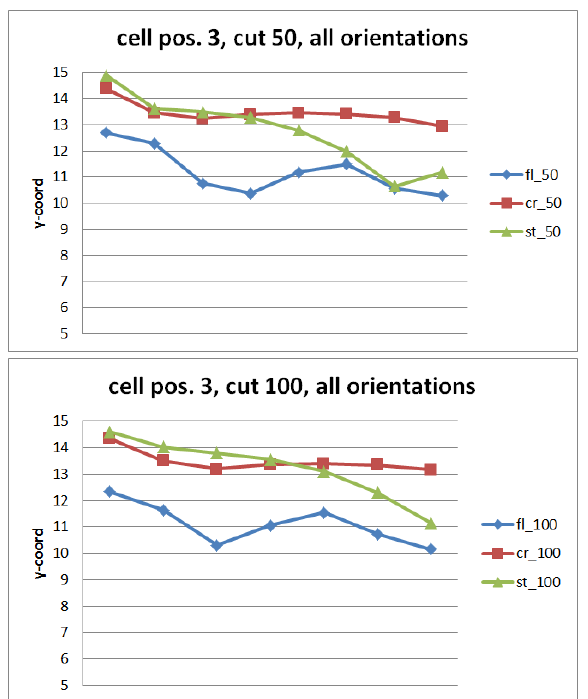
Fig.4. For cell in starting position 3 (15 μm from edge), for all orientations and cutting positions the tendency to change the trajectory is clearly visible. In this case the slope coefficients are -0.19813, -0.08924, -0.35882, -0.19956, -0.05978, -0.31496, -0.26794, -0.12479, -0.54526, -0.25306, -0.13050,